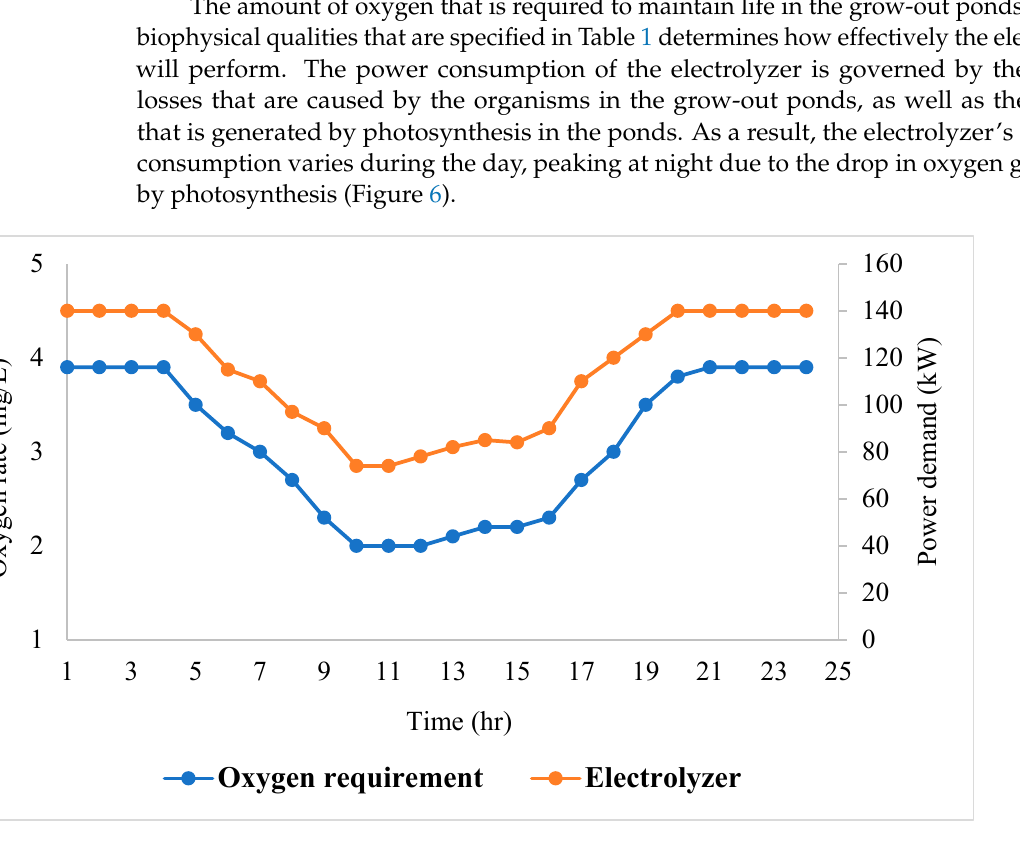
Figure 6. Hourly oxygen requirement and power demand at the shrimp farm with a base load of 1.2 mg/L.